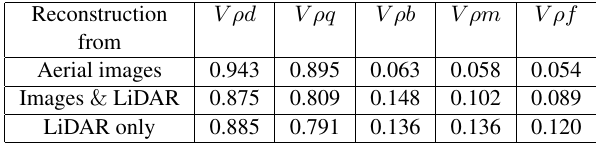
Table 7: 3D quality